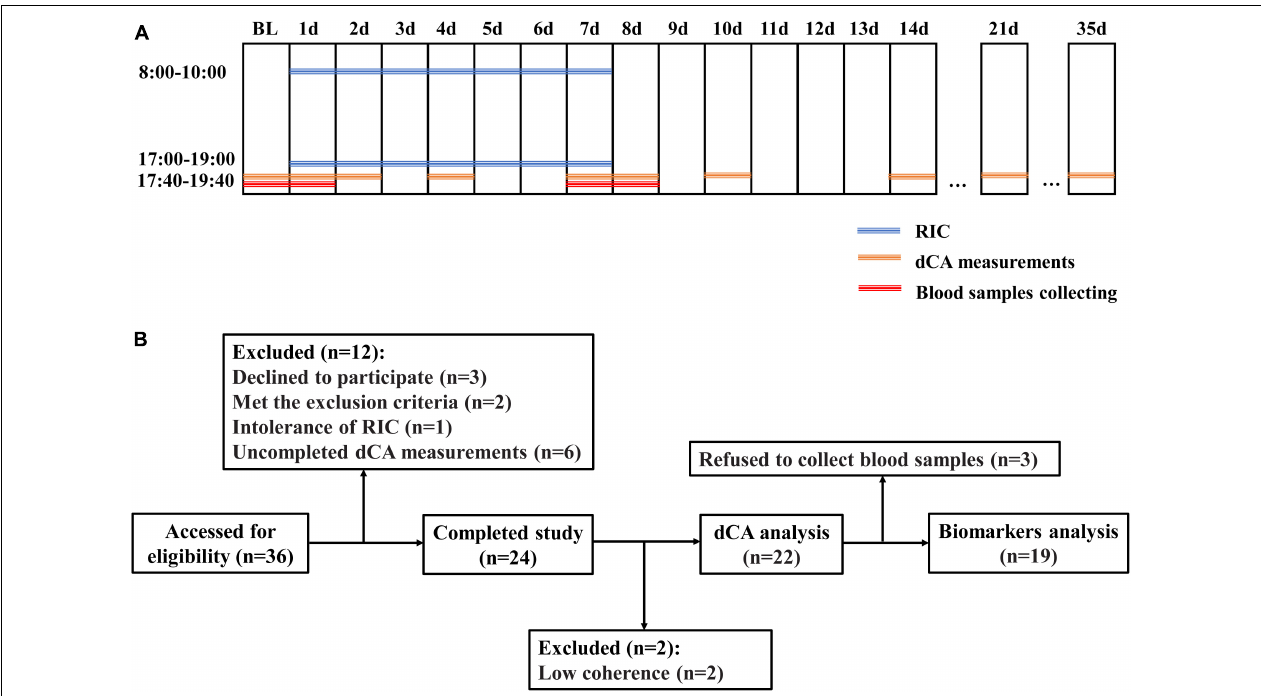
FIGURE 1 | (A) Protocols of the study. (B) Flowcharts of the study. BL, baseline; RIC, remote ischemic conditioning; and dCA, dynamic cerebral autoregulation.